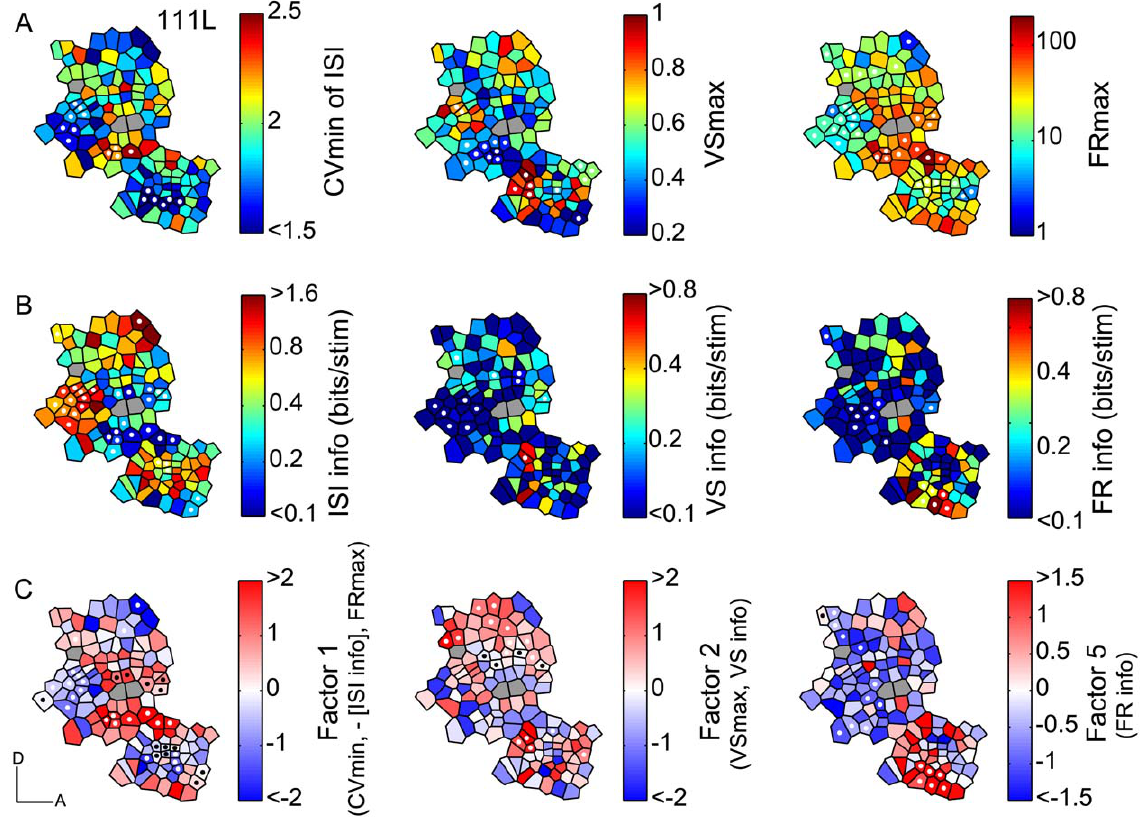
Figure 6. Spatial distributions of temporal response measures and mutual information. (A) Spatial distributions of CV min of ISI, VS max, and FR max for hemisphere 111L. Minimum or maximum value of the measures for any of the repetition rates is shown. White dots indicate polygons with statistically similar values as their direct neighbors (compared to random re-distribution of all neighbors, see Materials and Methods). Gray polygons indicate sites not available due to the four tested repetition rates, which also apply to (B, C). (B) Spatial distributions of mutual information values of ISI, VS, and FR based on repetition rate discrimination. (C) Spatial distribution of three temporal factors emerging from a principal component analysis of CV min, FR max, VS max, as well as the three corresponding information measures. Both white and black dots indicate polygons with statistically similar values as their direct neighbors.